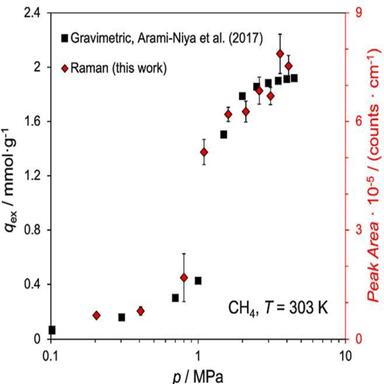
A comparison of methane adsorption profiles measured by a gravimetric method (adsorption capacity, black) and the Raman spectroscopic characterization (Raman peak area associated with adsorbed methane signals, red).